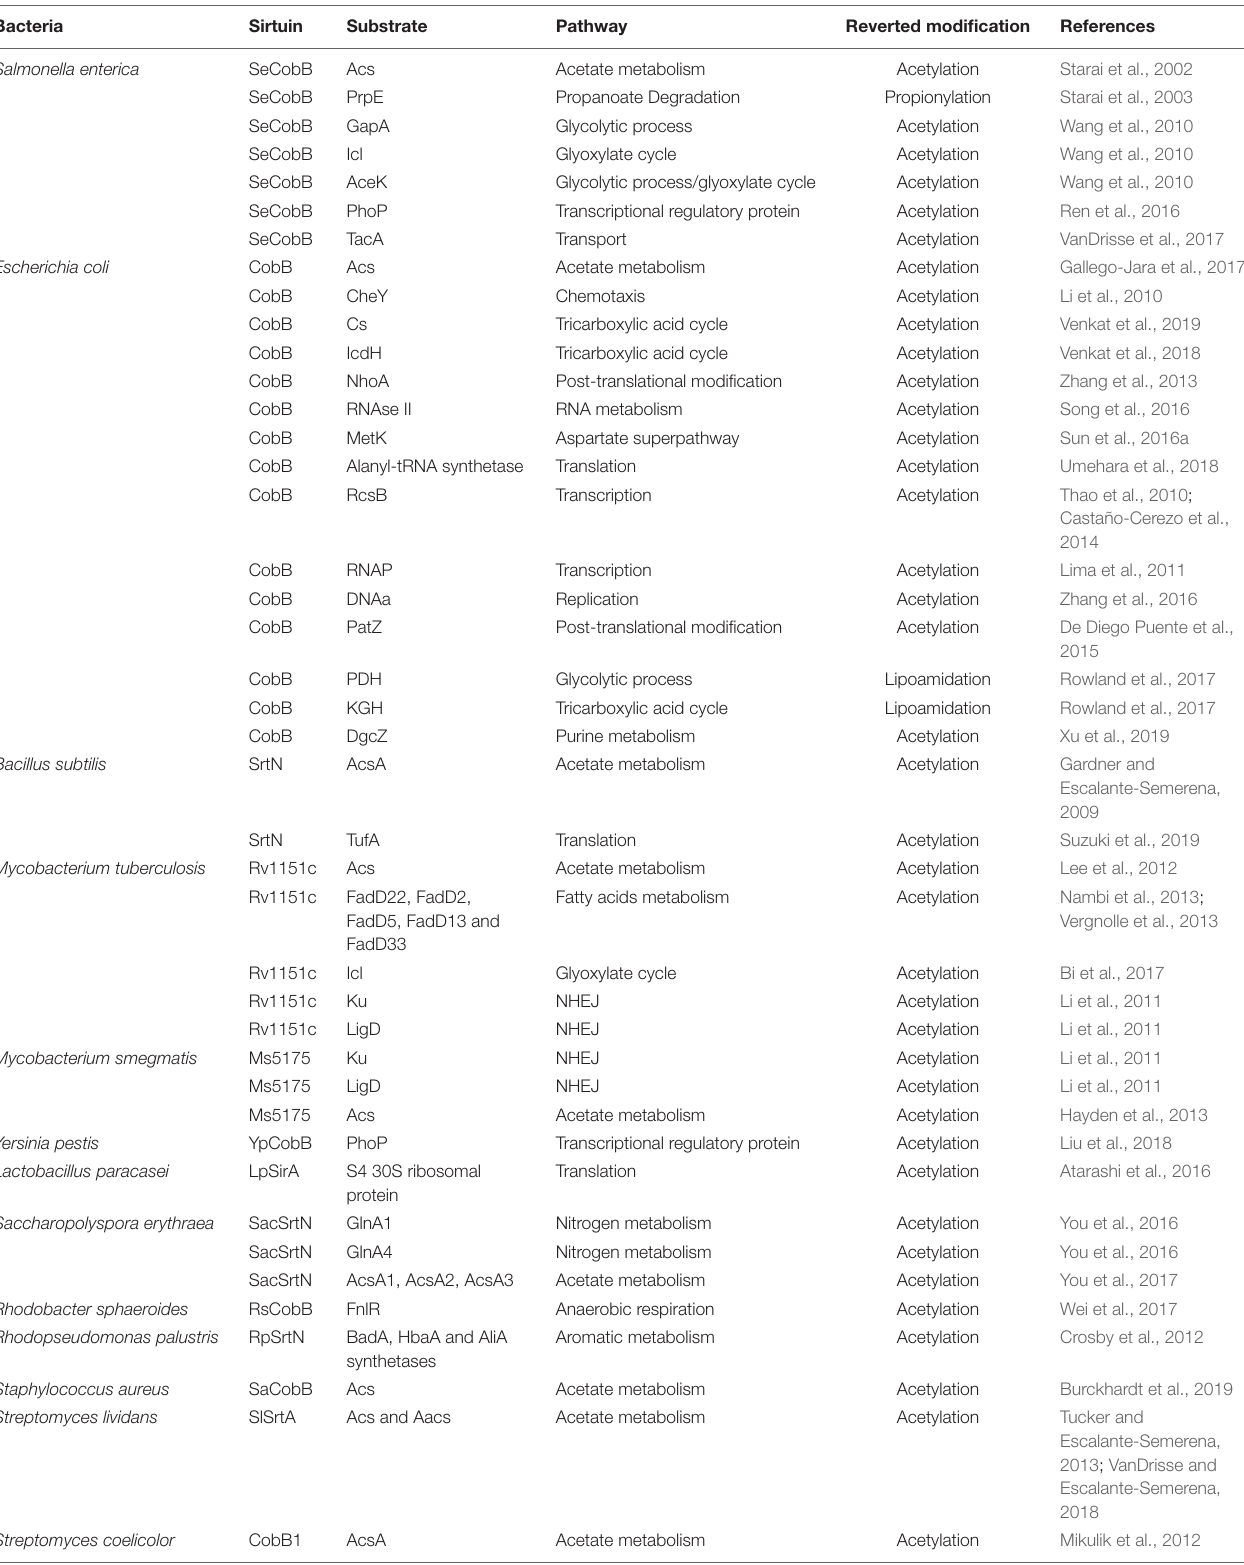
TABLE 1 | Bacterial sirtuins characterized substrates.